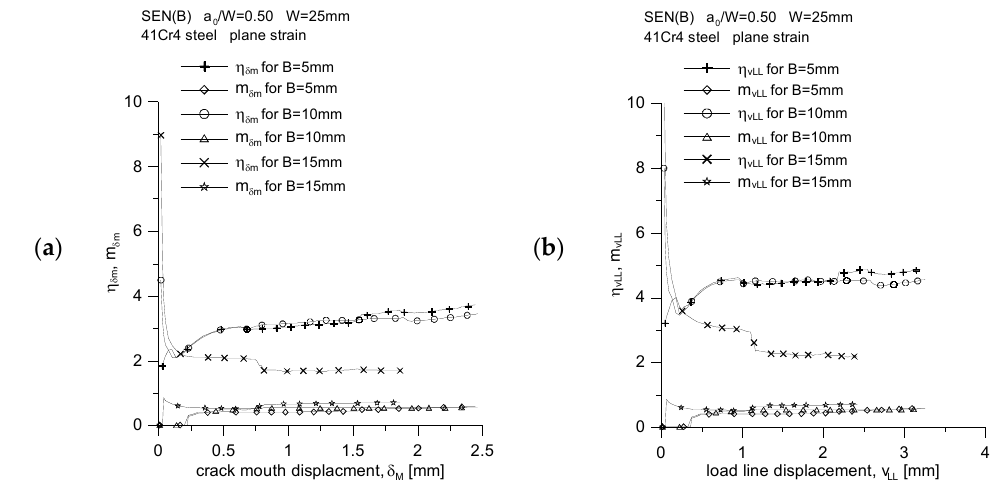
 vLL for B=5mm m vLL for B=5mm  vLL for B=10mm m vLL for B=10mm  vLL for B=15mm m vLL for